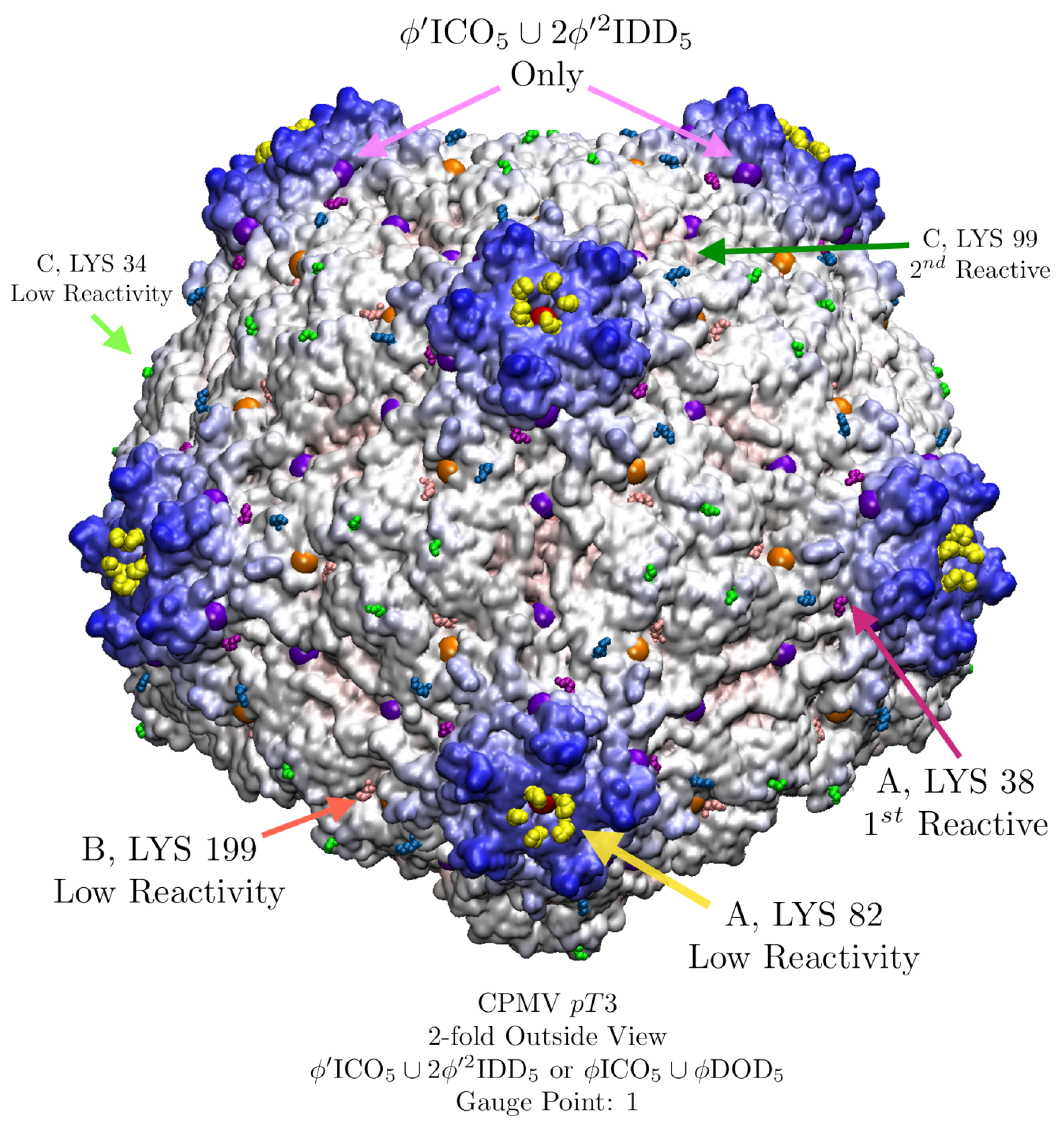
Figure 19. CPMV (pT3, 1ny7 [32]) has five solvent exposed exterior lysine residues found to be reactive which are labeled here by the protein domain they occupy [17]. There are two point arrays φ (cid:48) ICO 5 ∪ 2 φ (cid:48) 2 IDD 5 and φ ICO 5 ∪ φ DOD 5 that fit equally well with an RMSD of 1.5 Å and Gauge